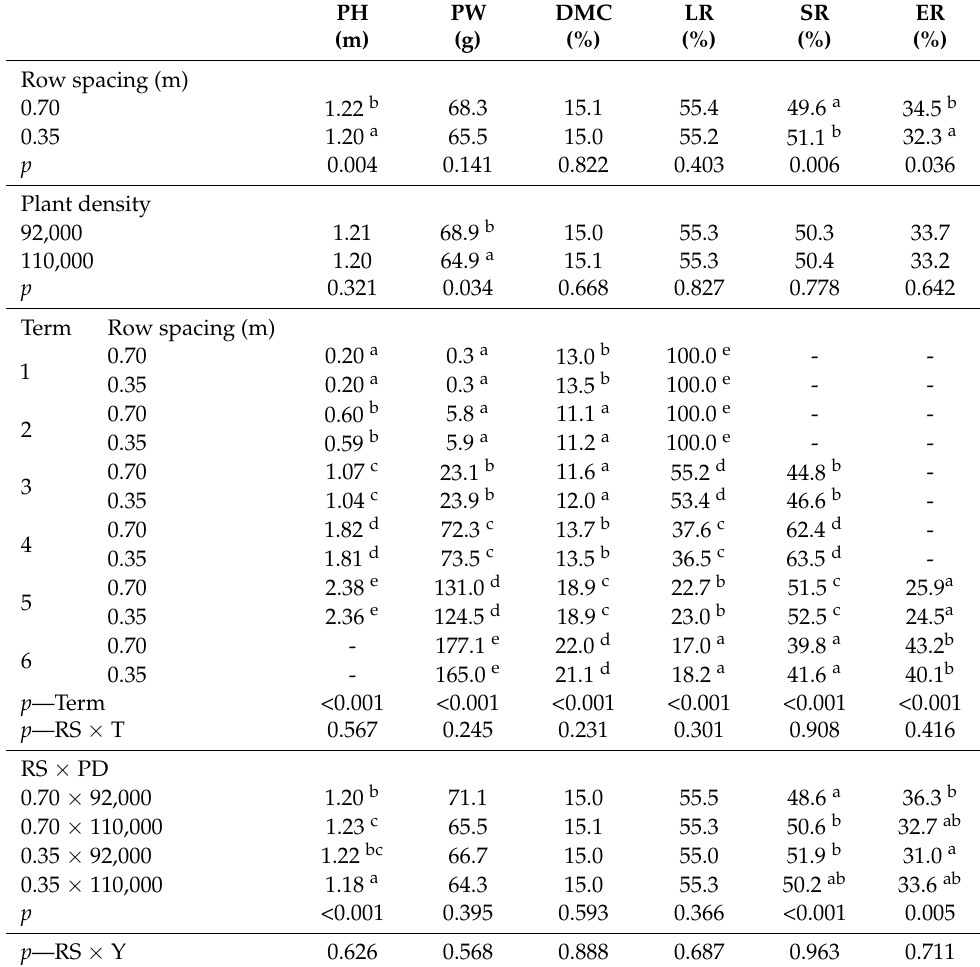
Table 5. Plant height (PH), plant weight (PW), dry matter content (DMC), leaf ratio (LR), stalk ratio (SR) and ear ratio (ER) for two row spacings (RS, 0.70 m and 0.35 m) and two plant densities (PD, 92,000 and 110,000 plants ha − 1 ) in six terms (T, see dates in Table 2) during the growing seasons in 2013–2014 (Y).